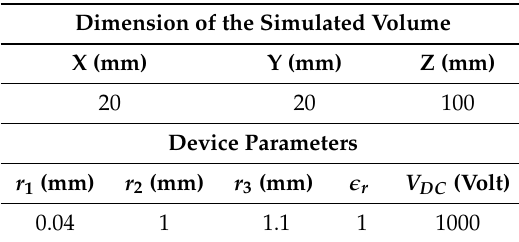
Figure 5. Cross-section of the inner and outer conductors of the proposed device. Table 1. System